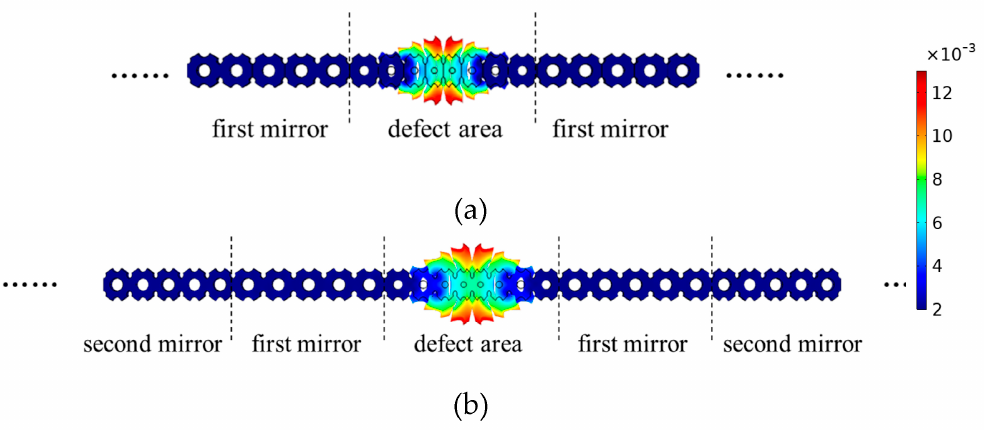
Figure 4. ( a , b ) Mechanical vibration mode diagram of the single − mirror and the hetero − optome- chanical crystal nanobeam resonators,